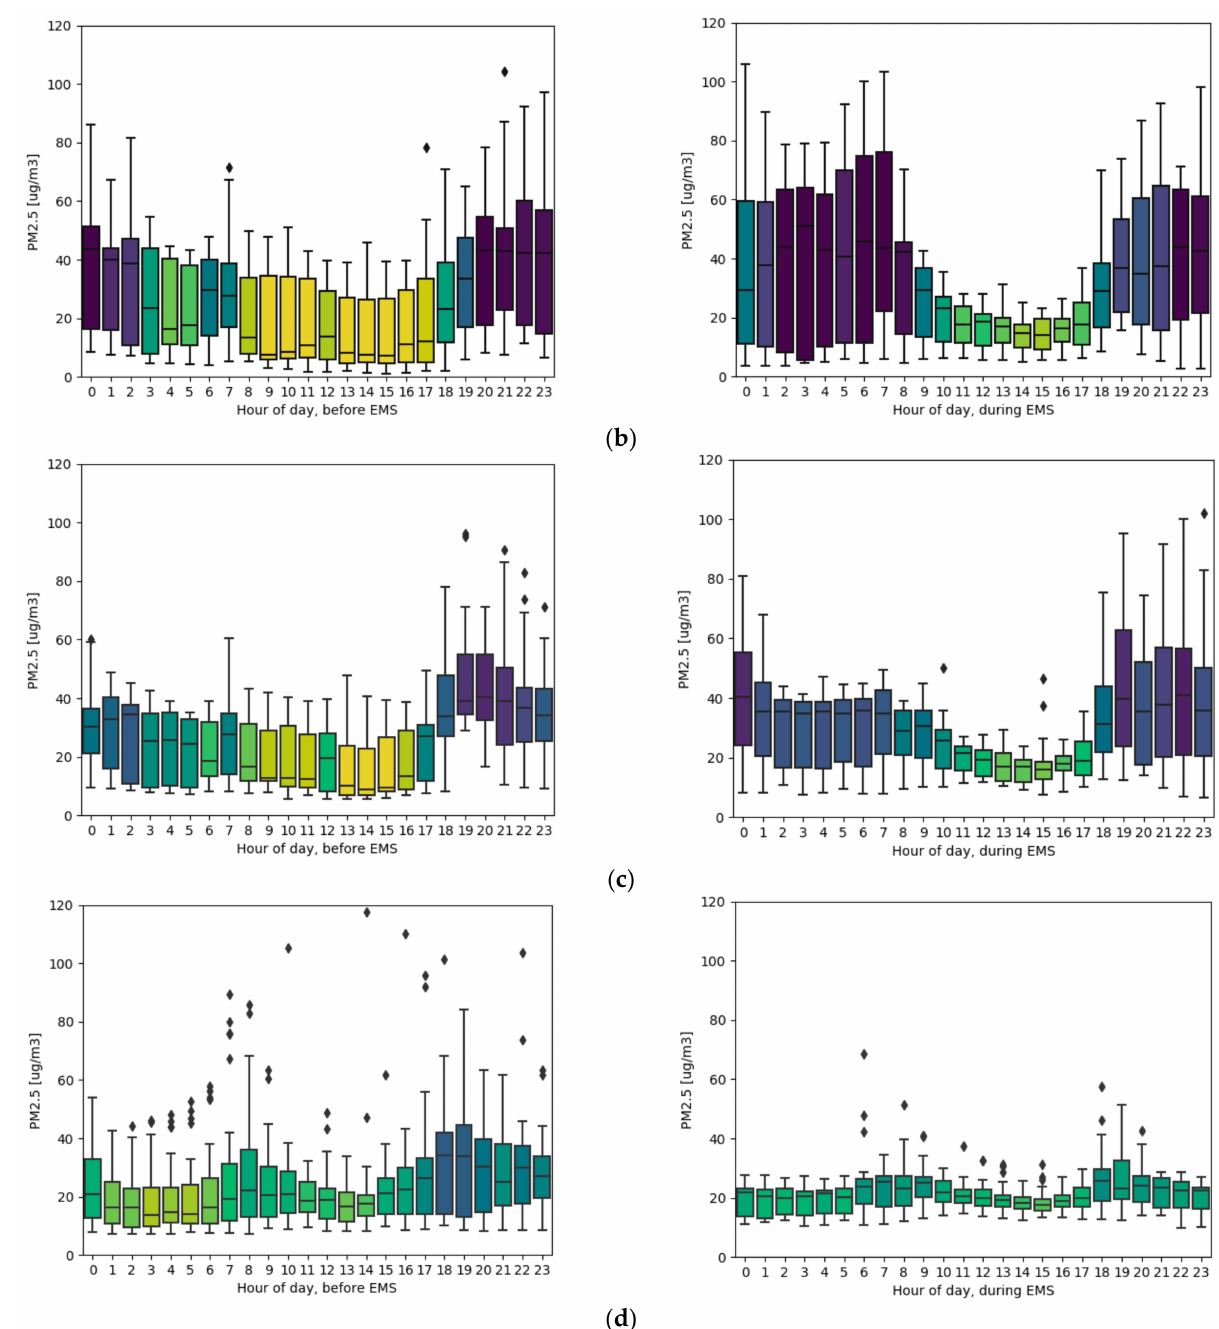
Figure 5. Daily profile of PM 2.5 measured before measures of the state of emergency ( left ) and during measures of the state of emergency ( right ) at ( a ) MS1 ( b ) MS2 ( c ) MS3 ( d )